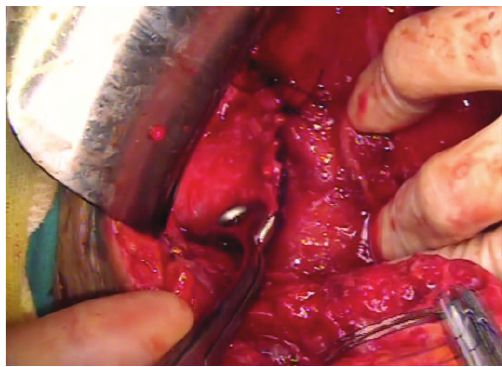
Figure 2: Intraoperative image showing resuturing the